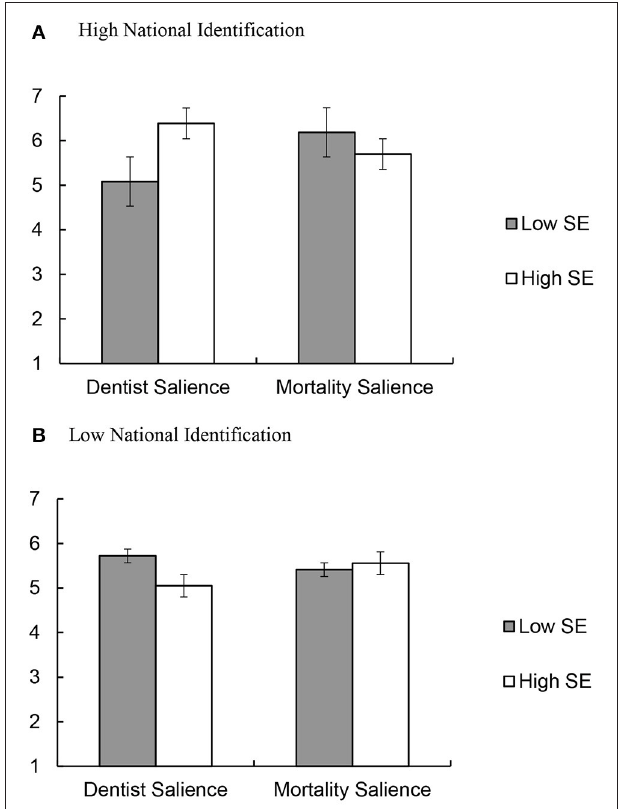
FIGURE 2 | Support for the Sinterklaas tradition as a function of mortality salience and self-esteem among participants (A) high vs. (B) low on identification. Low and high levels of identification, mortality salience and self-esteem were coded as 1 SD below and above the mean, respectively. The items were rated on a scale from 1, completely disagree to 7, completely agree